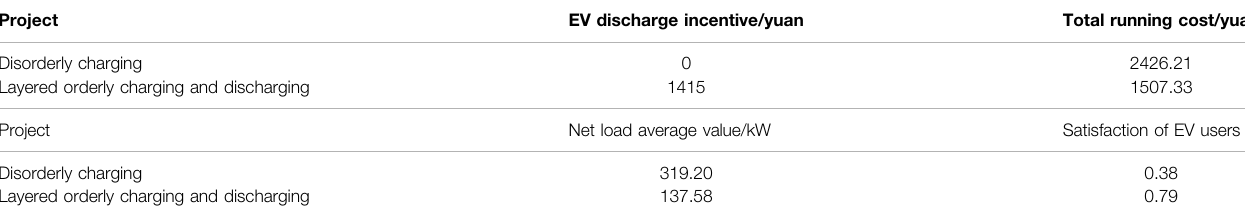
TABLE 2 | Comparison of the results of disordered charging and hierarchically ordered charging and discharging of